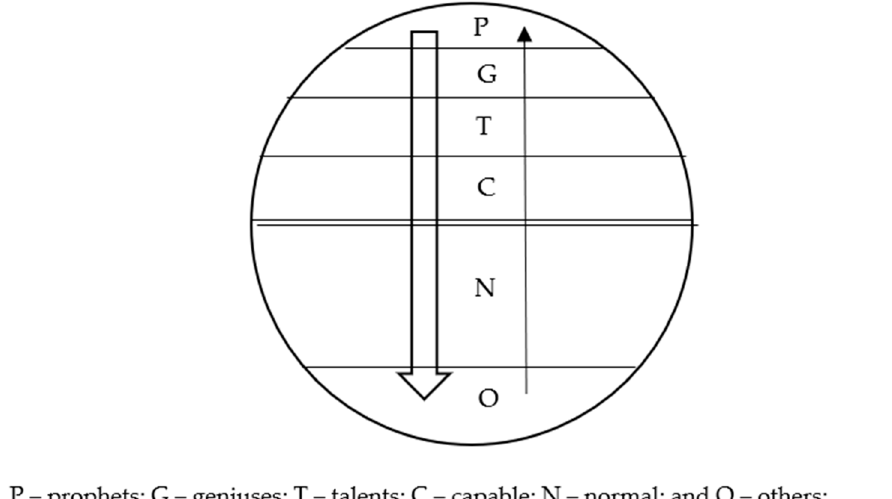
Figure 2. Model of person’s development in society.